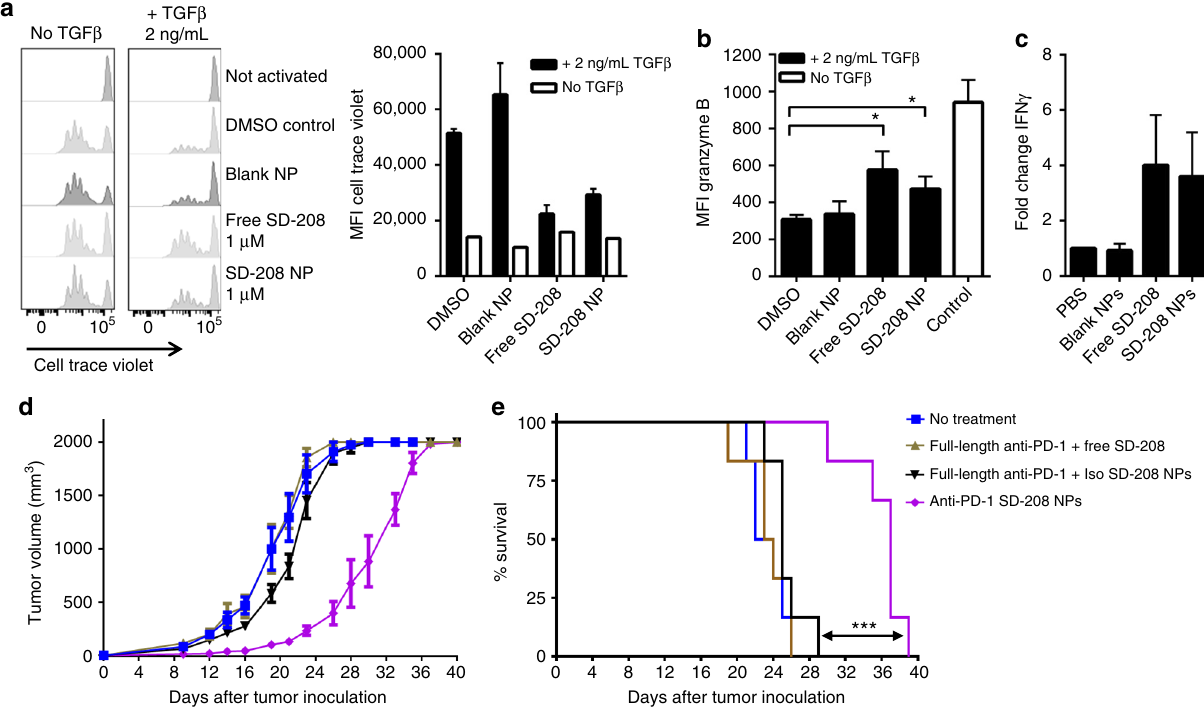
Fig. 5 Targeted delivery of a TGF β R1 inhibitor (SD-208) to PD-1-expressing cells delays tumor growth and extends survival. a Proliferation of CD8 + T cells following activation with anti-CD3/CD28 beads (1:2 bead to T cell ratio) for 72 h in the presence or absence of TGF β 1 (2 ng mL − 1 ) and treatment with 1 μ M SD-208 as free compound or as nanoparticle formulation; quanti fi cation of geometric mean of cell trace violet is provided in the right panel, n = 3, mean ± s.d. b Intracellular granzyme B expression was assessed by fl ow cytometry, n = 3, mean ± s.d. (* p < 0.05, one-way ANOVA with Tukey ’ s post hoc test). c Fold change of interferon- γ (IFN γ ) was measured by ELISA, n = 4, mean ± s.e.m. d , e C57BL/6 were inoculated subcutaneously with MC38 cells. Five days later, nanoparticles or free drugs were administered intravenously every other day up to a total of 10 injections. The dose was 20 μ g of anti-PD-1 and 40 μ g of SD-208. d Tumor volume and e animal survival were monitored to assess ef fi cacy, n = 6, mean ± s.e.m.; (*** p < 0.001, Mantel-Cox